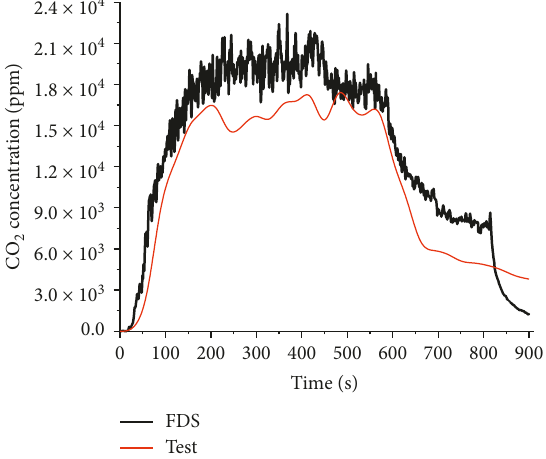
Figure 6: CO 2 concentration in test and FDS.